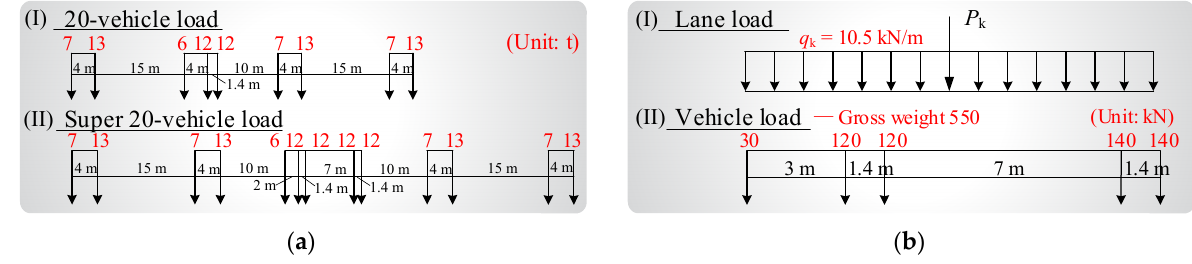
Figure 2. Traffic load models in the Chinese bridge design codes: ( a ) MOT (1985); ( b ) MOT (2004 and 2015).